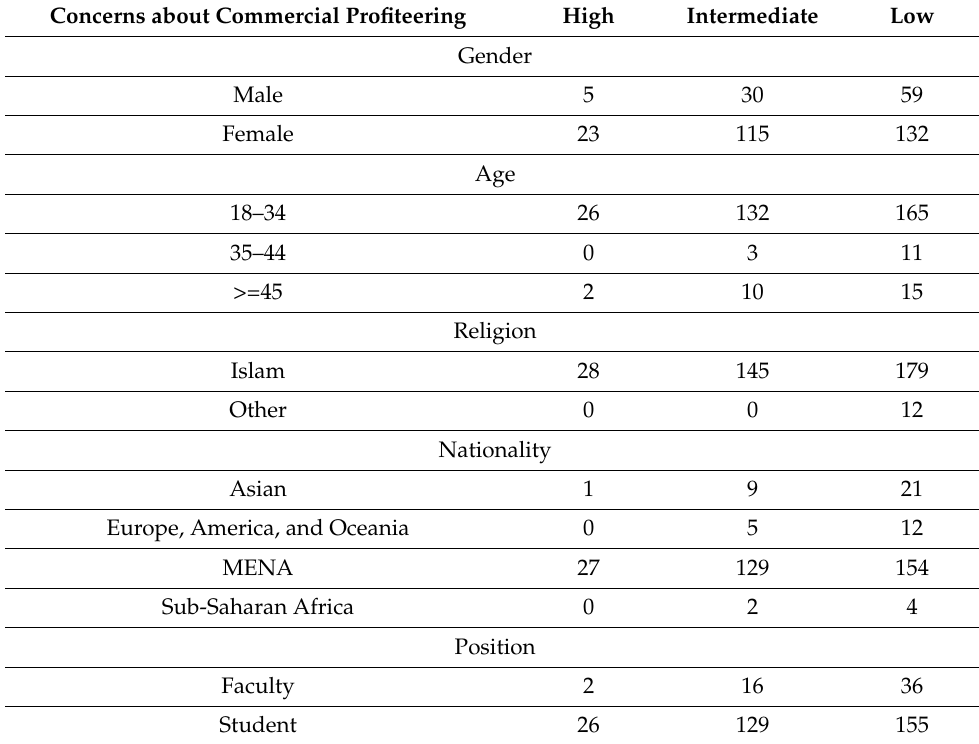
Table A3. Actual number of participants in Concerns About Commercial Profiteering